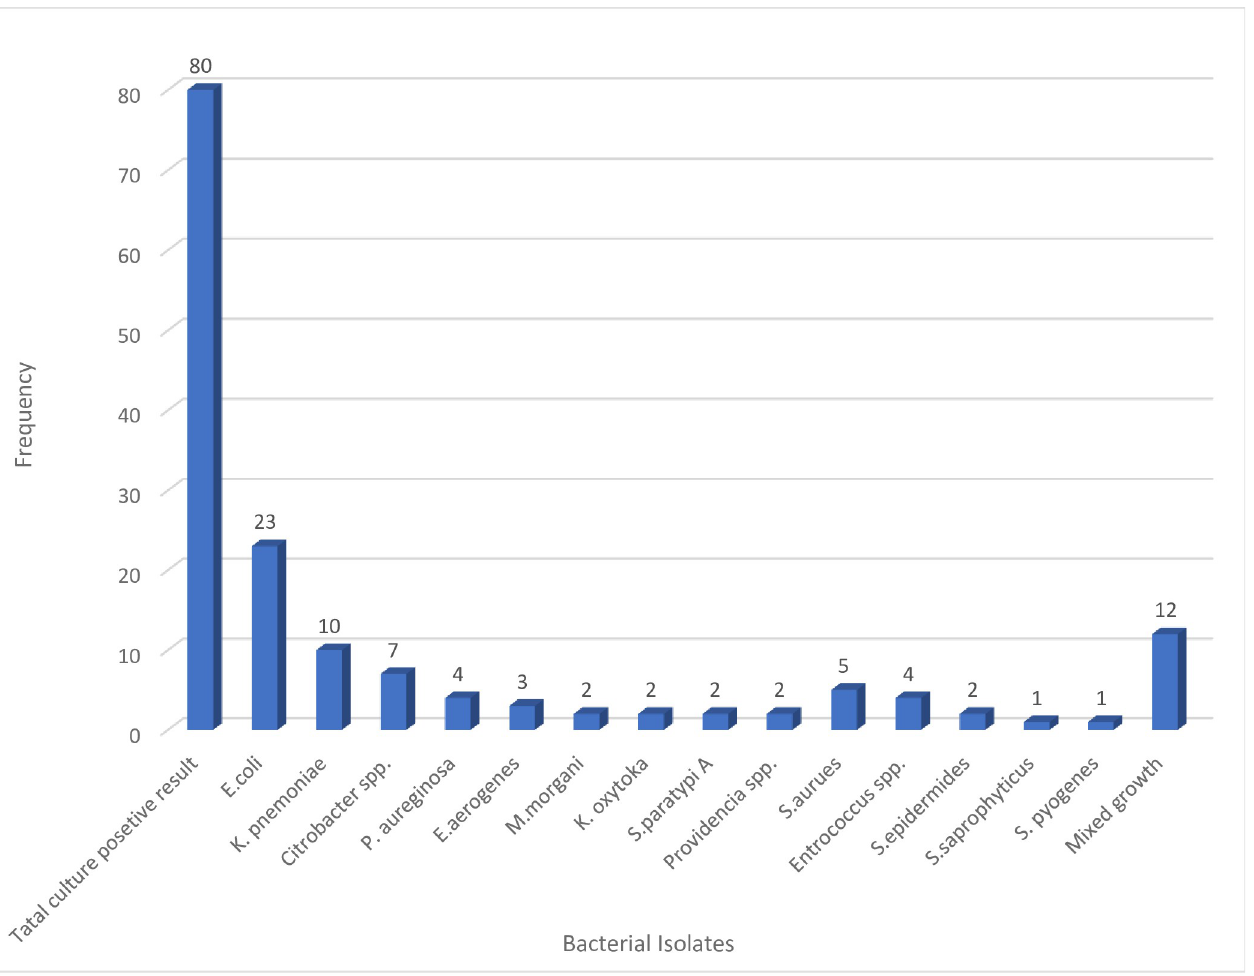
Fig 1. Frequency and type of bacterial isolated from the urine of under-five children at HFSUH, eastern Ethiopia,